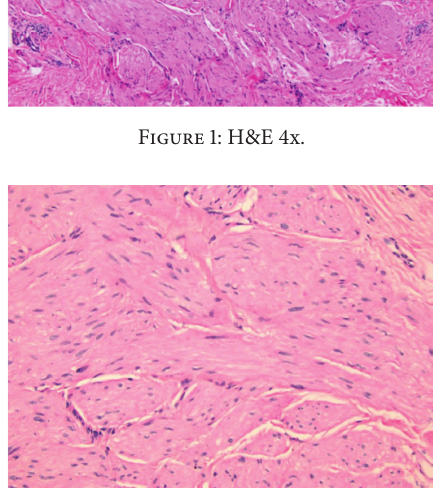
Figure 2: H&E 20x.